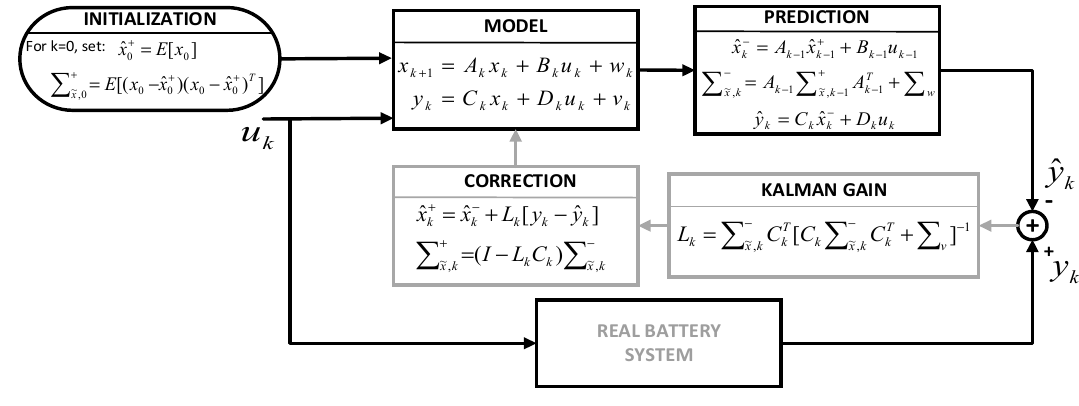
Figure 7. Kalman filter iteration diagram.